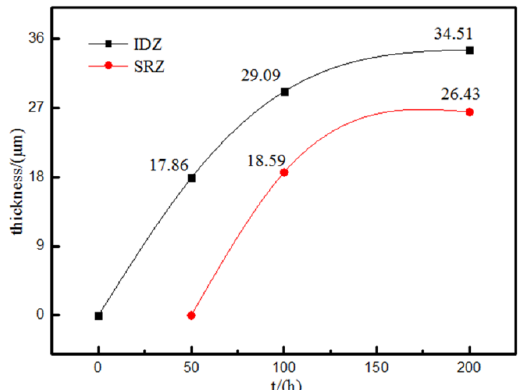
Figure 5. Variation of interdiffusion zone (IDZ) and secondary reaction zone (SRZ) for NiCoCrAlY coating/N5 single crystal superalloy with static oxidation time at 1100 °C.